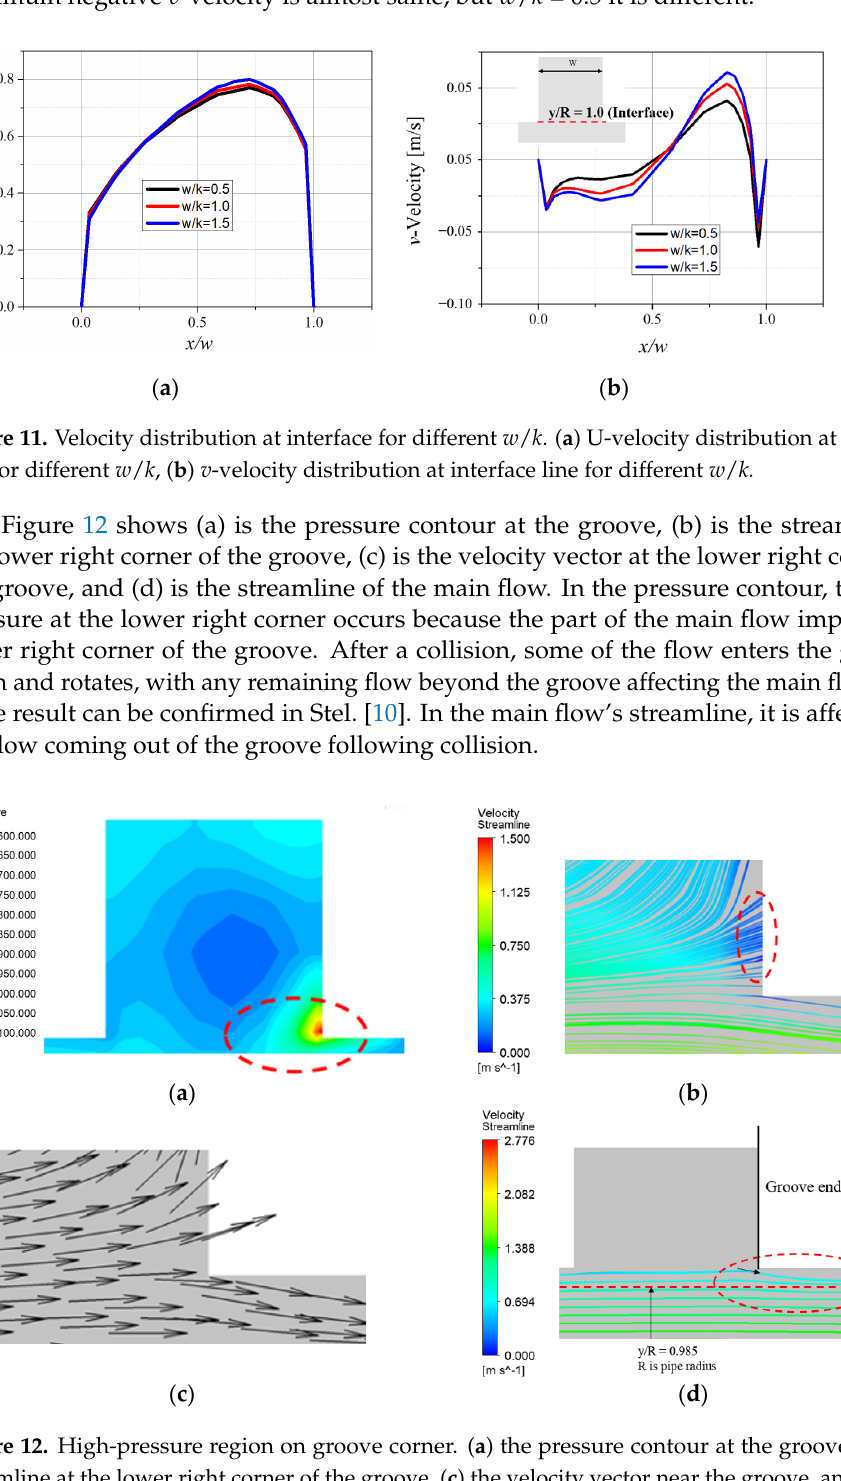
Figure 10. The velocity vector and distribution for corrugated pipe inside the groove : ( a ) The velocity vectors in the groove for the various ratios of w / k and ( b ) its v -velocity distribution. Figure 11 represents the velocity profiles at the interface between the groove and the main flow. Profiles of (a) and (b) represent u -, and v -velocity profiles, respectively. For the u -velocity, it increases as the height decreases. Where u -velocity is the x-direction of the velocity component. For the v -velocity, the lower the height, the magnitude of v -velocity is larger at the groove interface because the flow rotates faster inside the groove. The maximum negative v -velocity values are shown at x/w = 0.9. For w / k = 1.0 and 1.5, the maximum negative v -velocity is almost same, but w / k = 0.5 it is different.